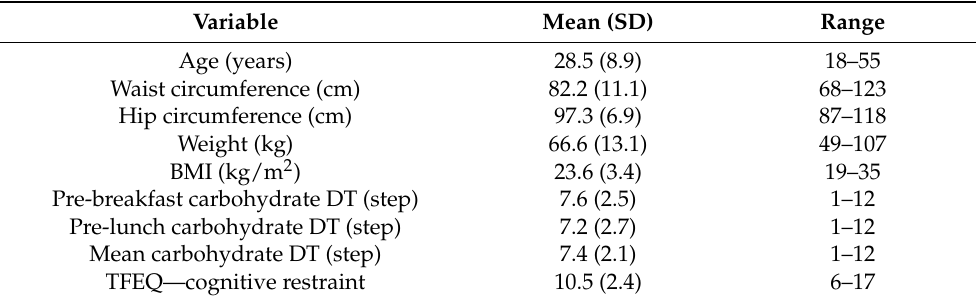
Table 2. Aggregate results for demographic, anthropometric, carbohydrate detection threshold and Three Factor Eating Questionnaire